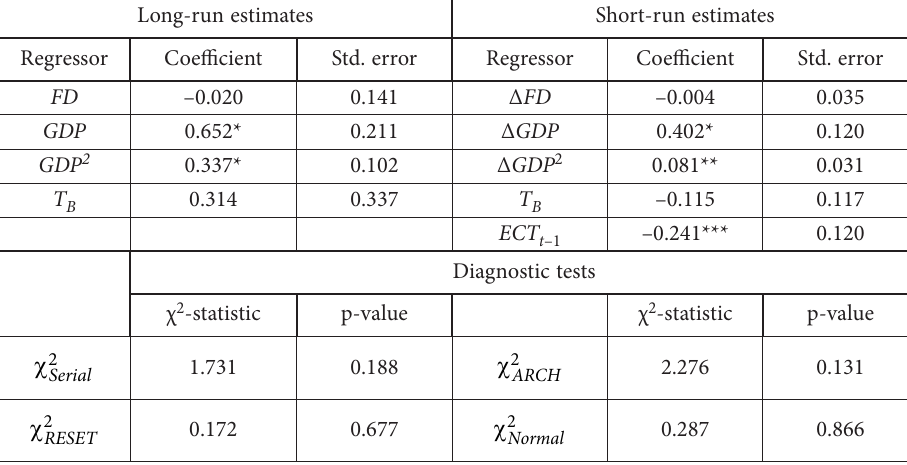
Table 7. The results for ARDL-ECM (1,0,2,0,1) results